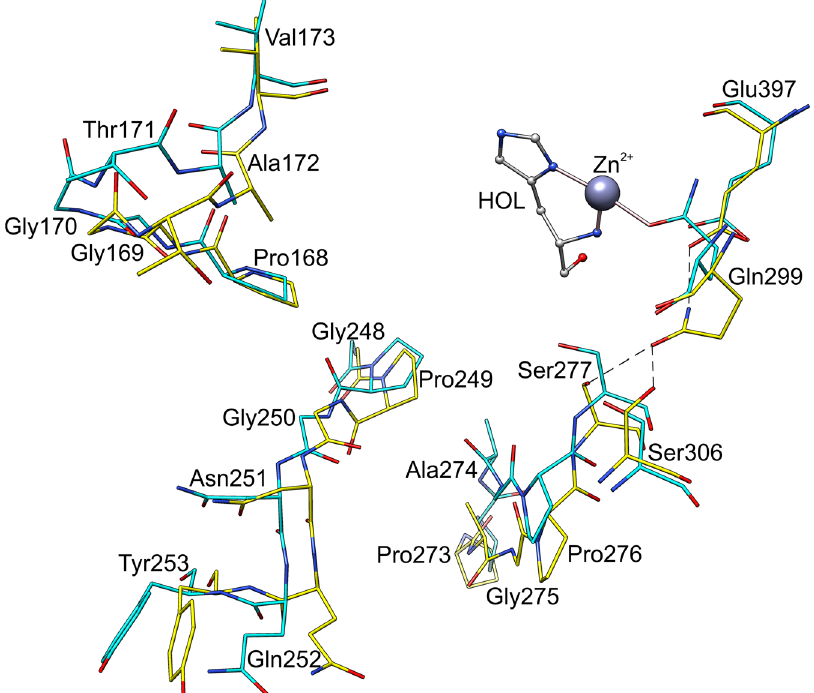
Figure 5. Fragments of the Mt HDH structure that undergo the most significant rearrangements upon HOL binding. Carbon atoms of the Mt HDH/IMD complex are yellow, whereas those of Mt HDH/HOL are in cyan. Zn 2 + and HOL are added for